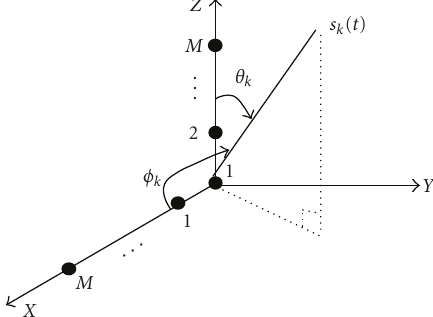
Figure 1: Array elements configuration for the joint elevation and azimuth DOA estimation